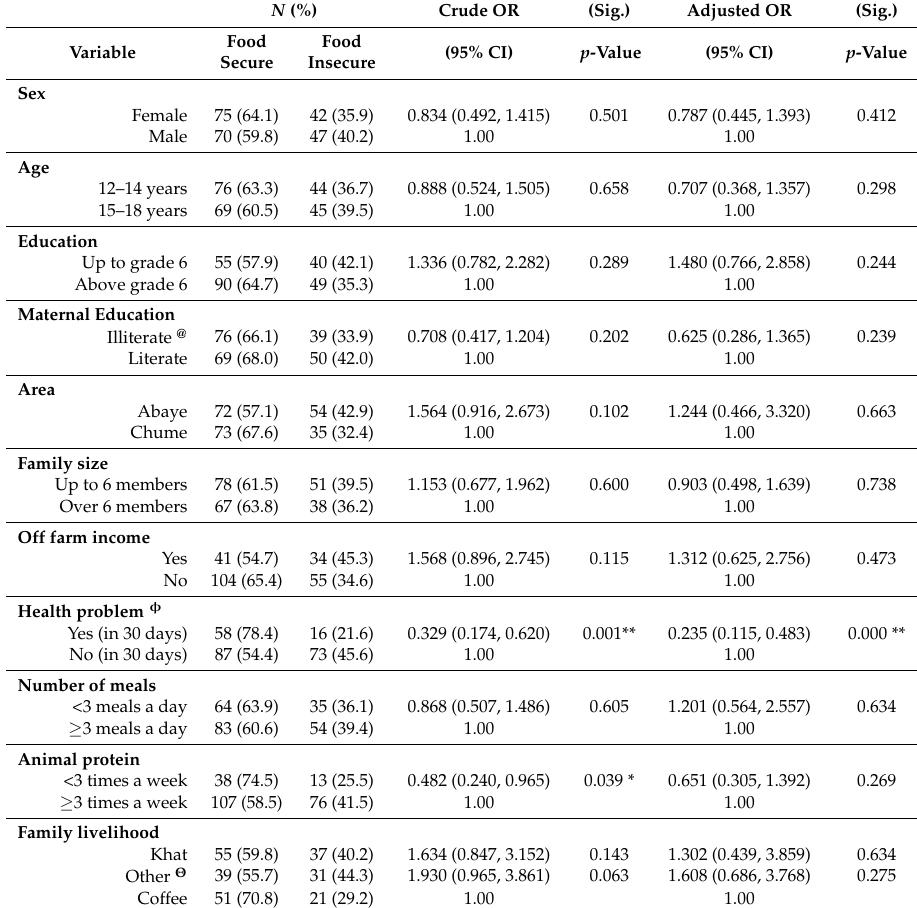
Table 4. Multivariate analyses of risk factors for adolescent food insecurity experiences (FIE) in the Sidama Zone, Southern Ethiopia. N (%) Crude OR (Sig.) Adjusted OR (Sig.) Food Food (95% CI) p -Value (95% Variable Secure Insecure